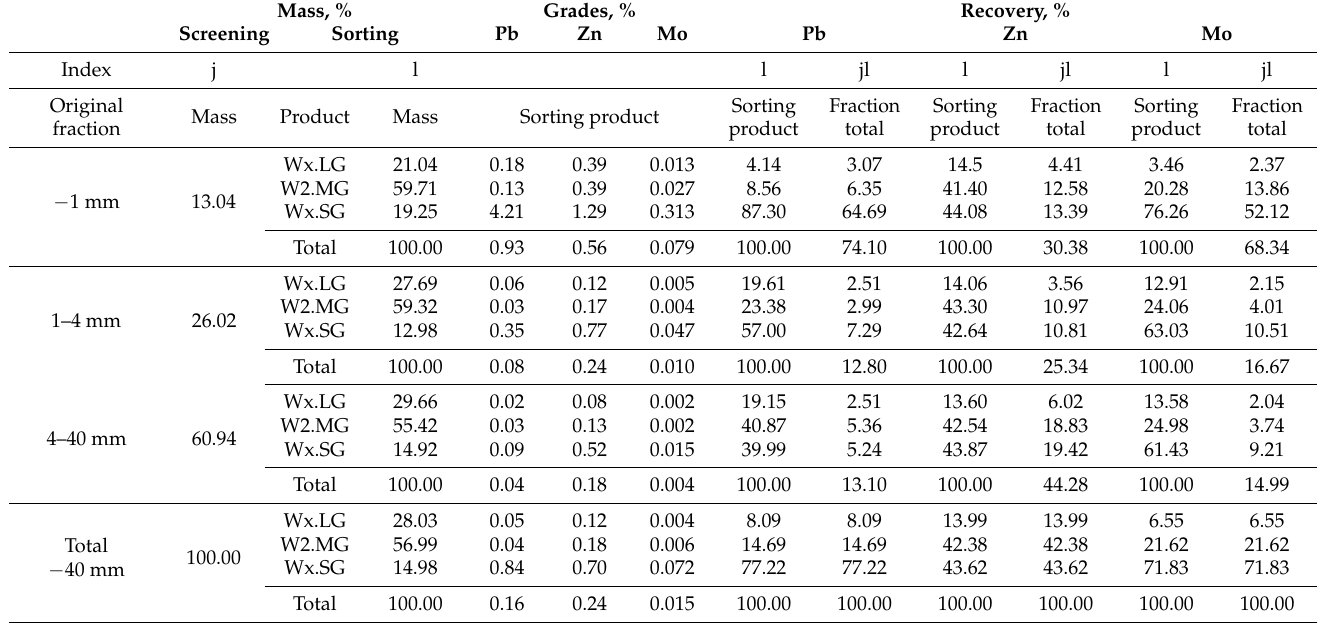
Table 10. Balanced results of the gravity concentration with spirals only. The sorted 30–315 µ m